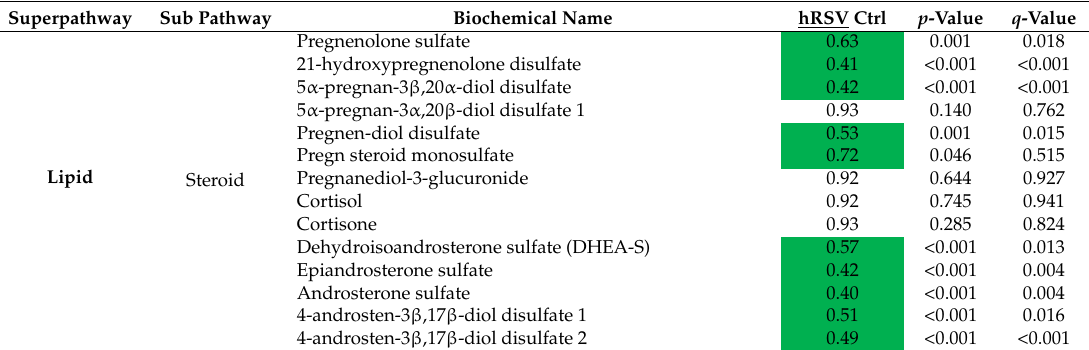
Figure 4. Resveratrol-mediated changes in plasma expressed as Pathway enrichment values (PEV). Values are based on the significant resveratrol-regulated compounds relative to all detected compounds in the pathway. PEV = (number of significant metabolites in pathway/total number of detected metabolites in pathway)/(total number of significant metabolites/total number of detected metabolites). Table 3. Summary of resveratrol-induced changes in plasma. Identified metabolites in the steroid, fatty acid dicarboxylate, and histidine metabolism pathways in plasma. Red: Significant elevation ( p ≤ 0.05). Orange: Trending elevation ( p < 0.10); Green: Significant reduction ( p ≤ 0.05). Light green: Trending reduction ( p <